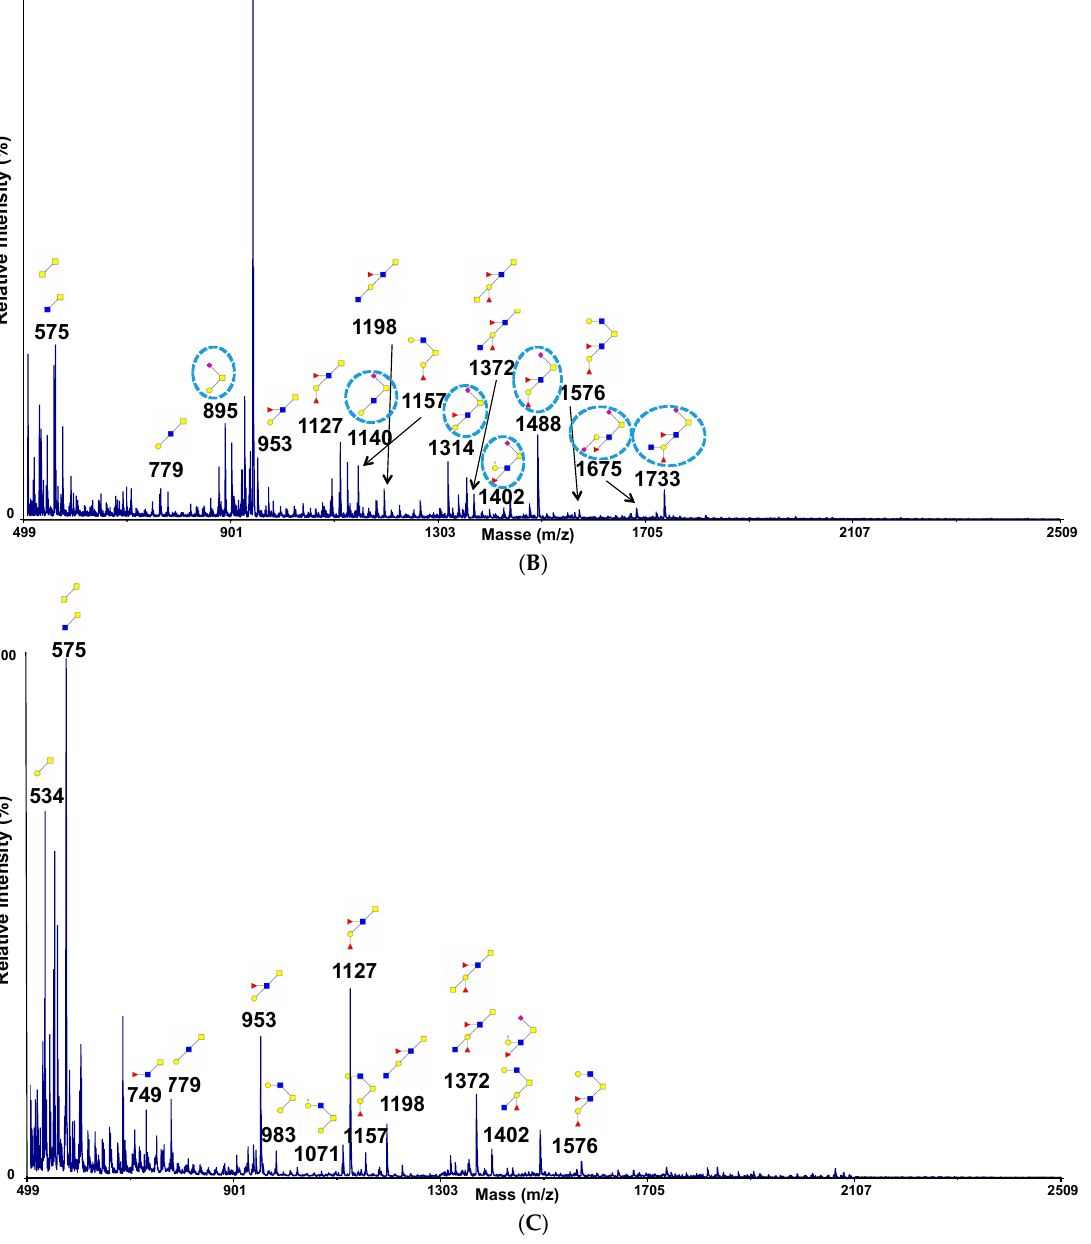
Figure 5. Influence of sialic acid residues on the adhesion of microorganisms to human mucins. ( A ) Bacteria and yeast preferentially bind to native human colonic mucins. The binding of DAPI-labeled microorganisms to pig gastric mucin (dark grey), human purified colonic mucins (light grey) and their desialylated counterparts (striped) was quantified by slot-blot overlay assays. A strong decrease of binding was observed for all microorganisms tested after chemical desialylation of mucins, the level of adhesion reaching that of PGM. Data shown is a representative experiment ± SD of three replicates. ( B , C ) MS spectra of permethylated O -glycans isolated from native ( B ) and desialylated human colonic mucins ( C ), acquired in the positive ion mode [M+Na] + . Monosaccharide symbols are used according to the Consortium for Functional Glycomics (CFG) nomenclature. Key: fucose (red triangle), GlcNAc (blue square), sialic acid (purple diamond), galactose (yellow circle), GalNAc-ol (yellow square) and sulfate residue (S).